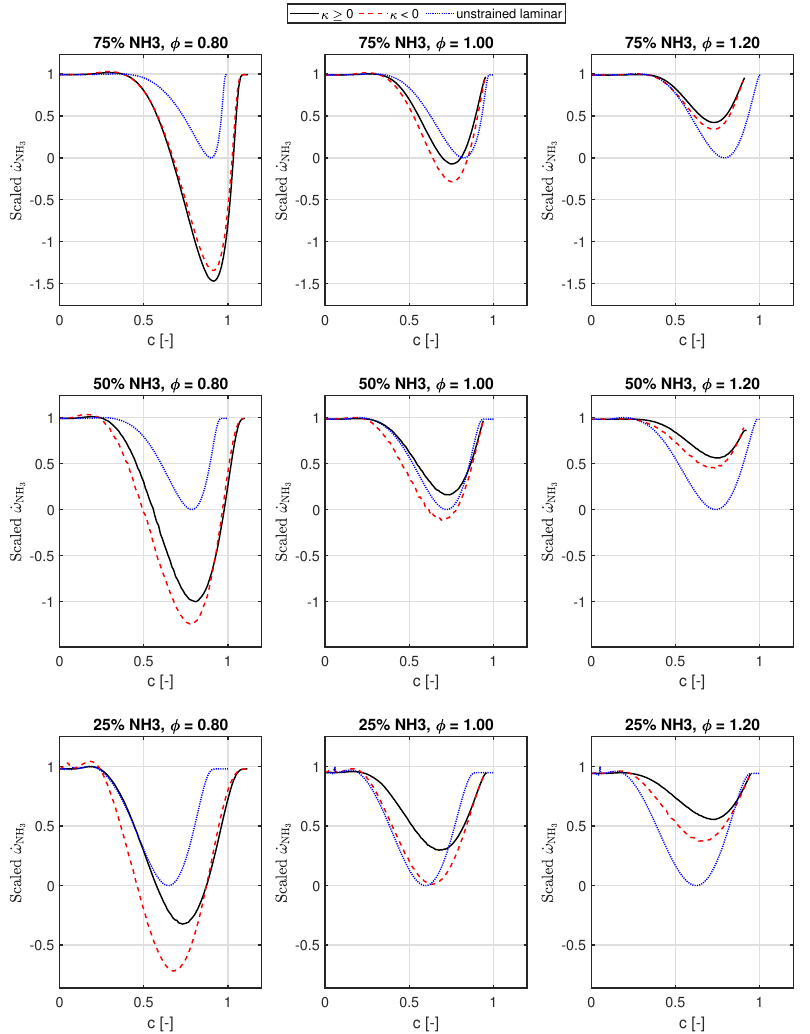
Figure 7. Conditional average of the source term of ammonia split by positive and negative curvature. The reaction rates of these reactions have been plotted in Figure